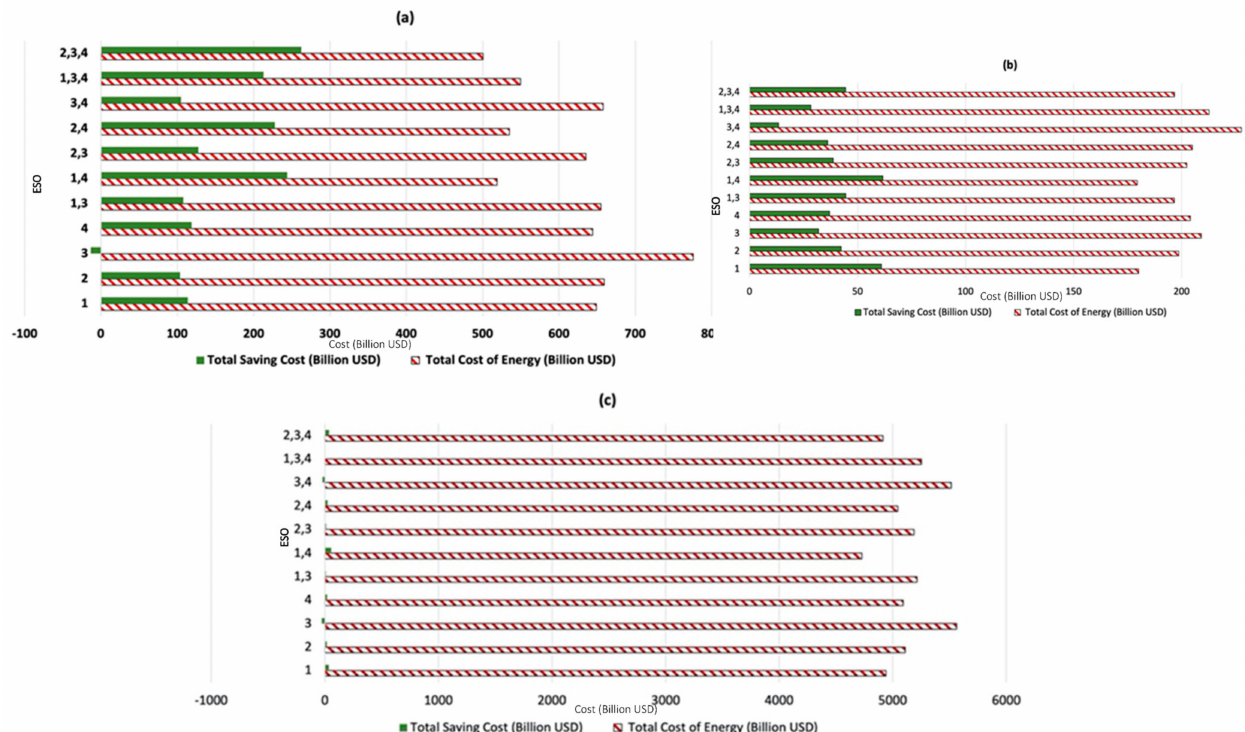
Figure 7. Comparison of cost of energy & ESO investment cost with saving cost between 2020 to 2050 in ( a ) detached residential building ( b ) attached residential building ( c ) low-rise apartment